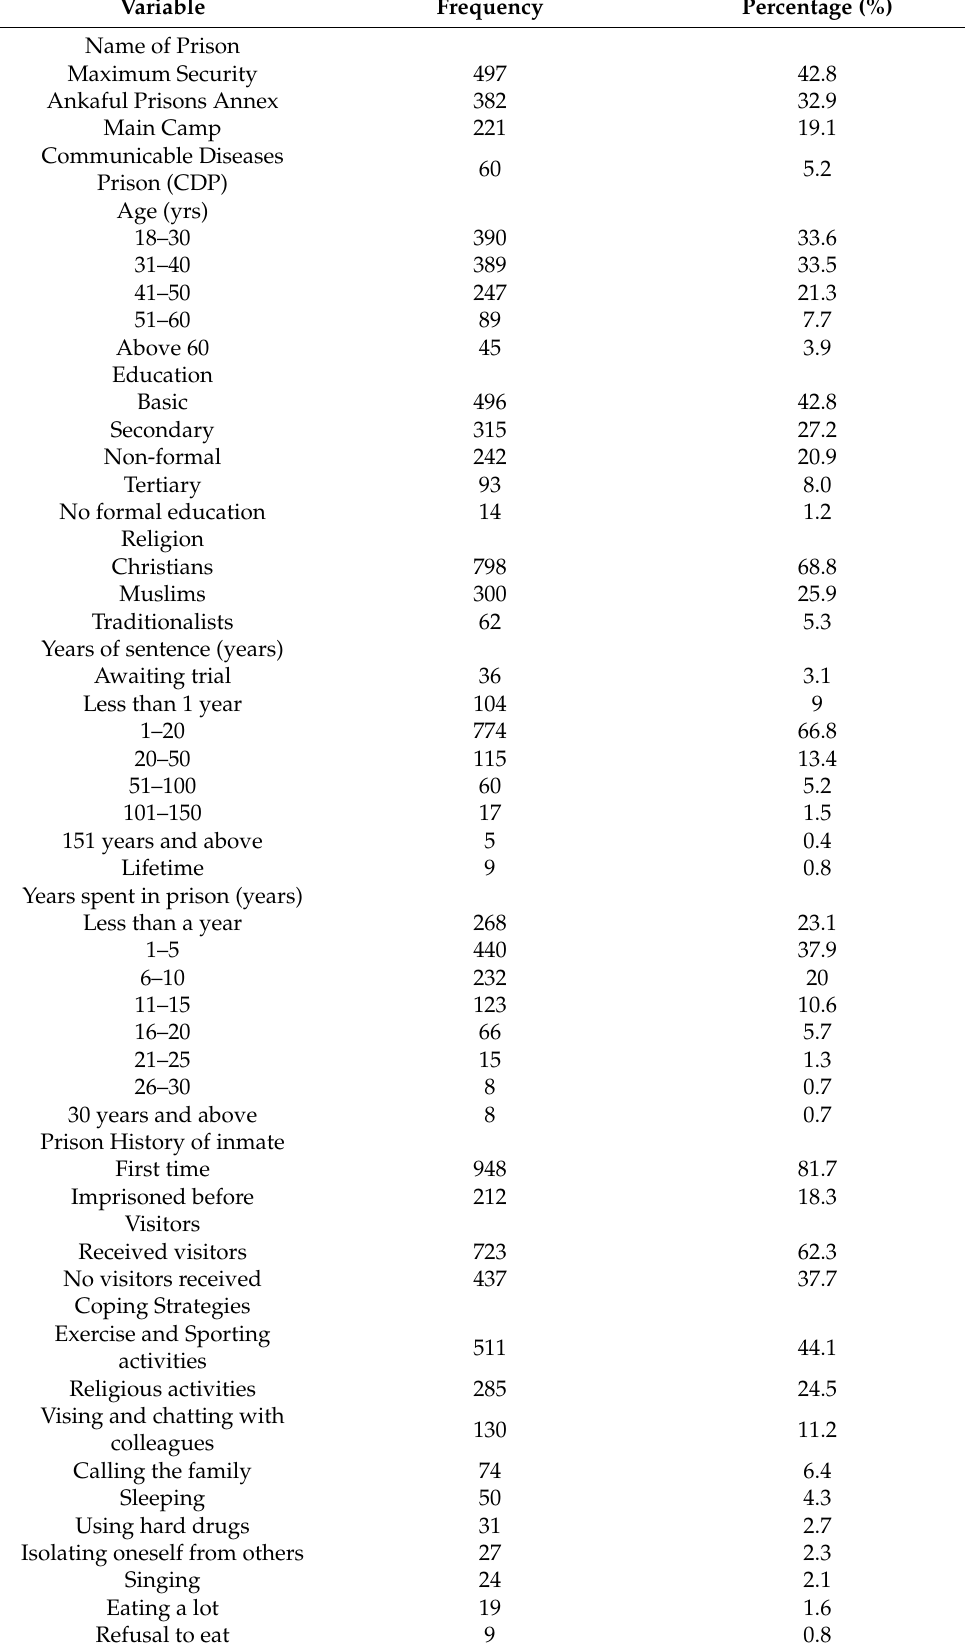
Table 1. Demographic characteristics of inmates of Ankaful Prison